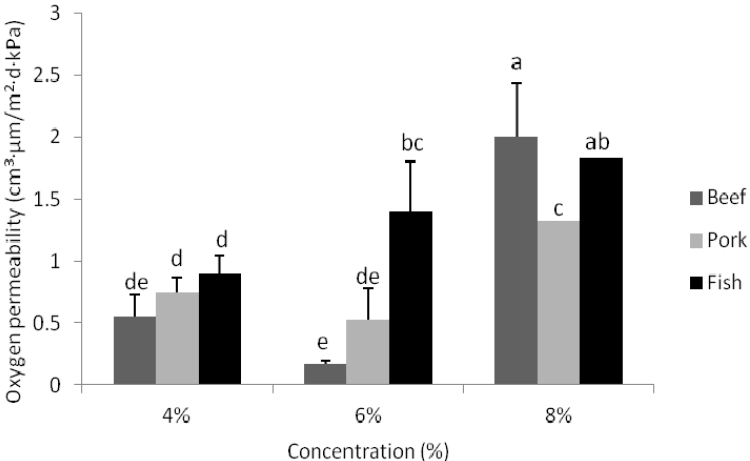
Figure 4. Oxygen permeability values of composite films derived from beef, pork and fish gelatin sources with the concentrations of 4%, 6% and 8%. Error bars represent standard deviations of data with letters indicate significant differences ( p < 0.05) between the oxygen permeability